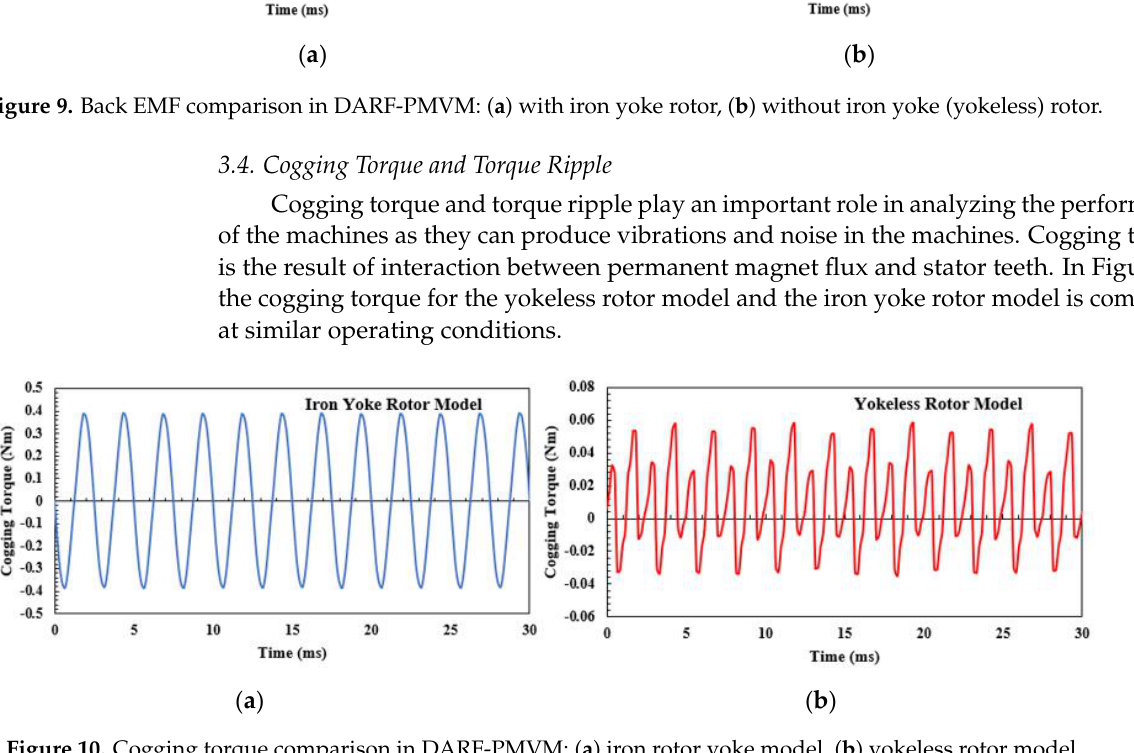
Figure 9. Back EMF comparison in DARF-PMVM: ( a ) with iron yoke rotor, ( b ) without iron yoke (yokeless) rotor.